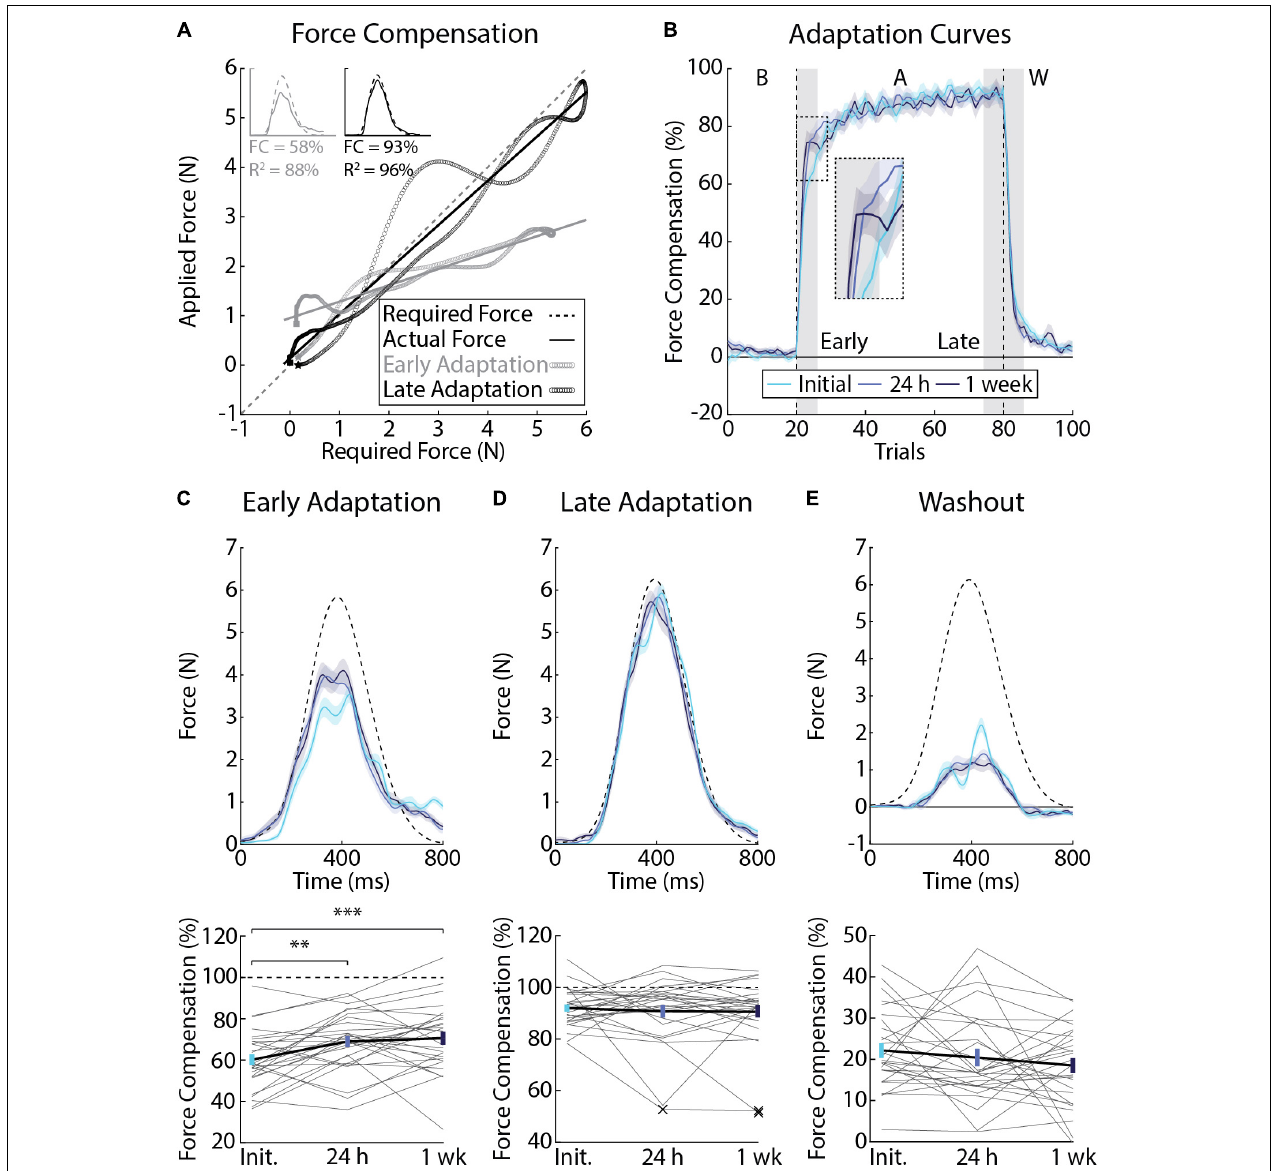
FIGURE 4 | Differences in force compensation across testing sessions ( Experiment 1 ). (A) Force profiles and linear regression from a representative participant showing the slope calculation for a single trial at the beginning (gray) and end (black) of adaptation. The force required to counter the force field is plotted on the x -axis and the actual force applied by the participant is plotted on the y -axis. Slopes were then converted to force compensation. (B) Average force compensation over the course of the experiment ( n = 28, 12 female). Lines represent the means from each session and shaded regions the corresponding SEM. Individual differences in adaptation were measured in the first ( Early Adaptation , inset panel) and last 3 blocks of adaptation ( Late Adaptation ) as well as the first 3 blocks of Washout (shaded gray regions). (C) Average force profiles and force compensation during Early Adaptation . Top: dashed line represents the ideal amount of force required to counter the force field, had it been applied. Solid lines represent mean force profiles and shaded regions indicate SEM. Bottom: gray lines indicate individual participant data measured across sessions. Error-bars indicate mean and SEM during Early Adaptation . Dashed line indicates force compensation = 100%. (D) Average force profiles and force compensation during Late Adaptation . “X” indicates multivariate outliers (Mahalanobis distance) that were excluded from the analysis. (E) Average force profiles and force compensation during Washout . Data in panels (D,E) are presented in the same manner as panel (C) . ∗∗ p < 0.01 and ∗∗∗ p < 0.001 after Bonferroni corrections (corrected for 3